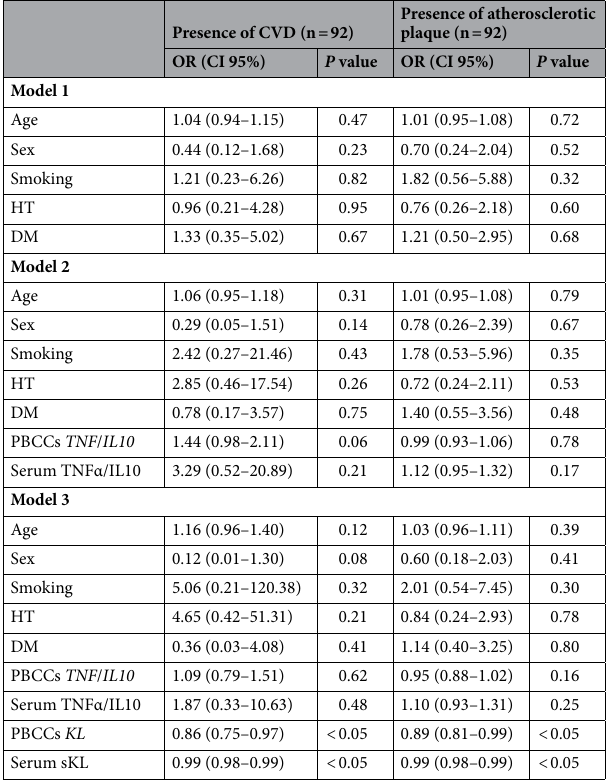
Table 4. Logistic regression analysis for presence of CVD or presence of atherosclerotic